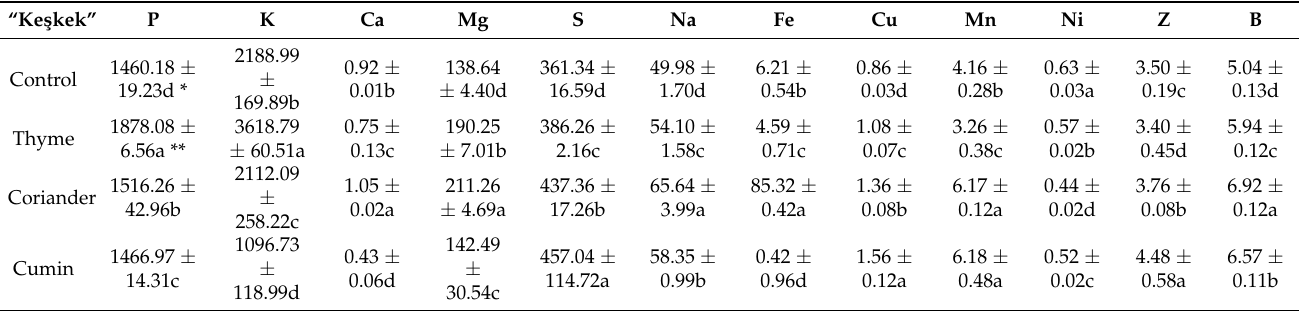
Table 4. Mineral content of “Ke¸skek” samples